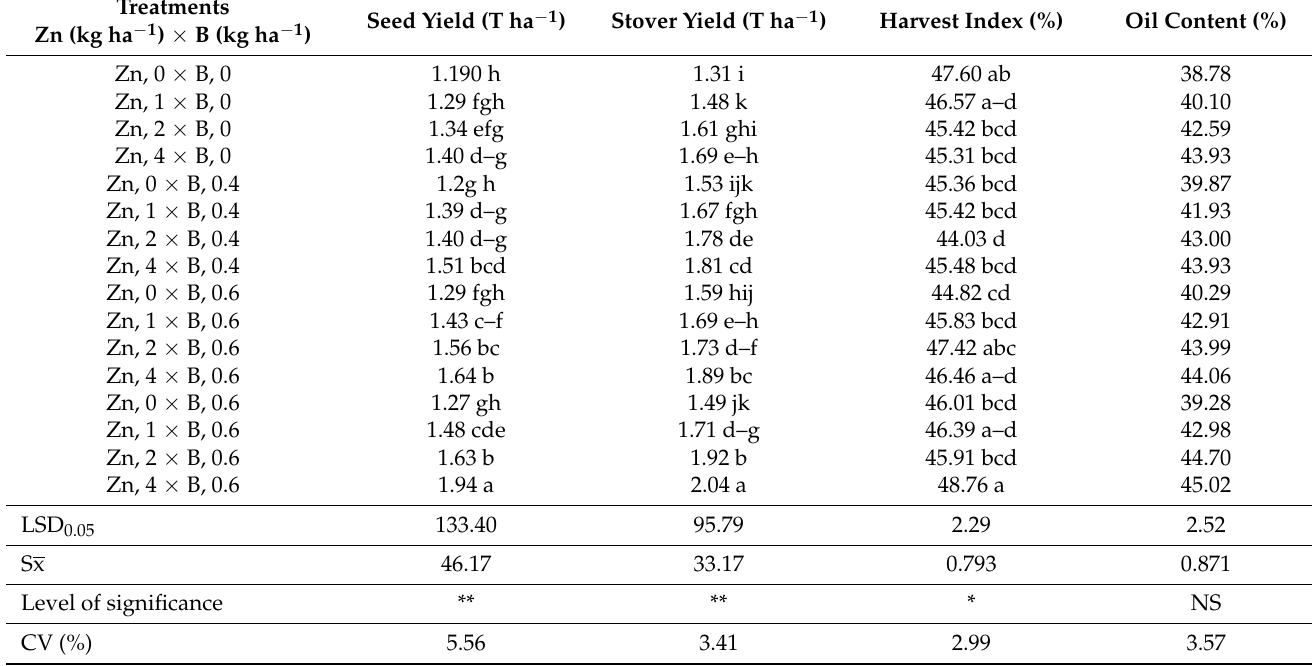
Table 2. Zn and B’s interaction effects on seed and stover yield, harvest index and oil content of Mustard (cv. BARI